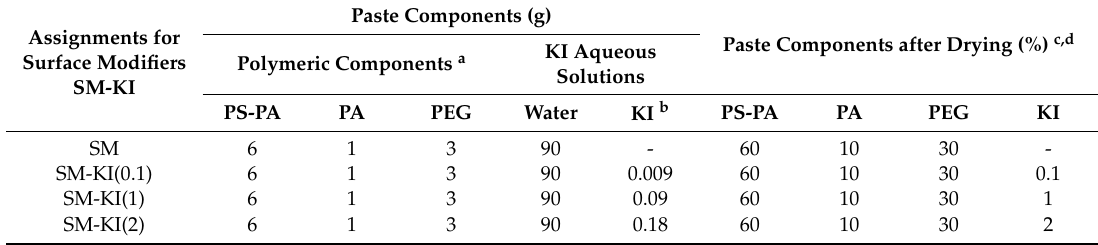
Table 2. Composition of the pastes of poly(lactide) (PLA) surface modifier